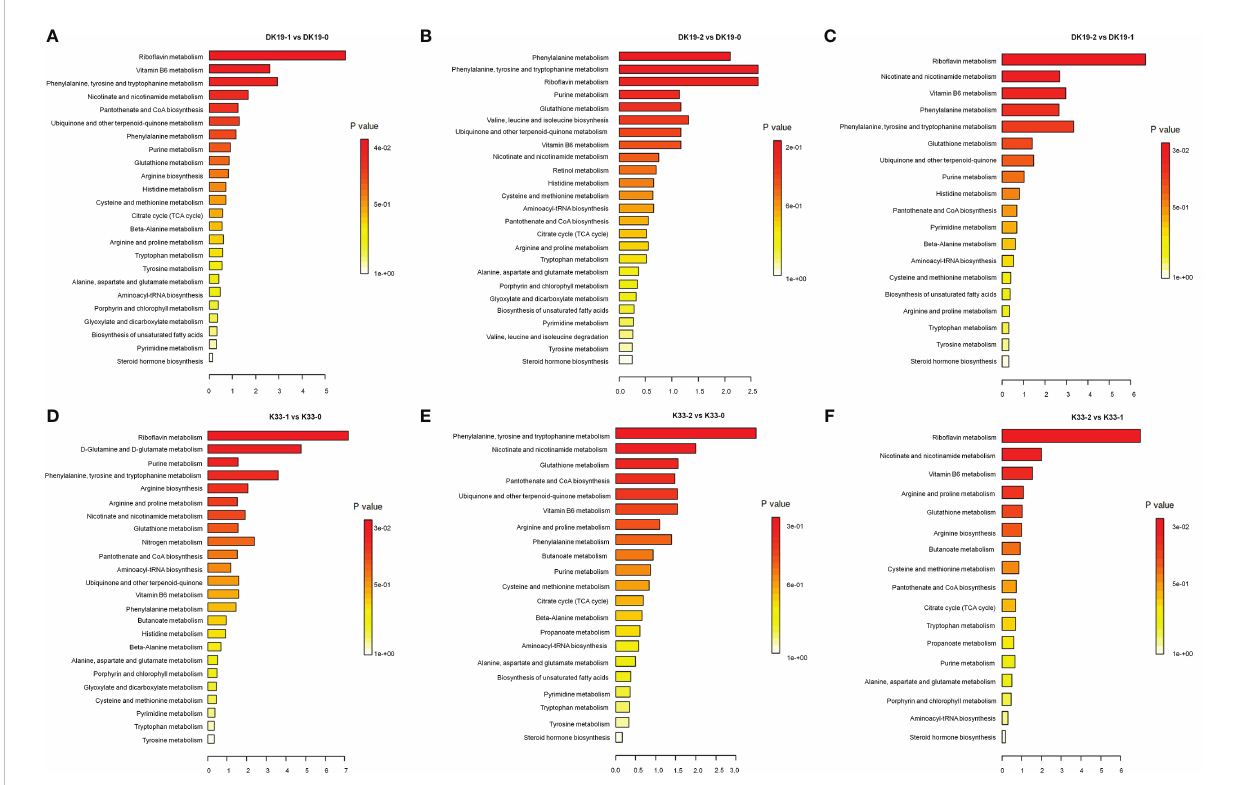
FIGURE 5 Screen of differentially accumulated metabolites (DAMs), generated using untargeted metabolomics sequencing. The Top KEGG pathways of all DAMs between different stages of treatment. The abscissa is the percent of differentially accumulated metabolites in different KEGG, and the ordinate is the type of KEGG enrichment. The darker the color, the higher the p value. (A – C) DAMs in DK19 between different stages of treatment. (D – F) DAMs in K33 between different stages of